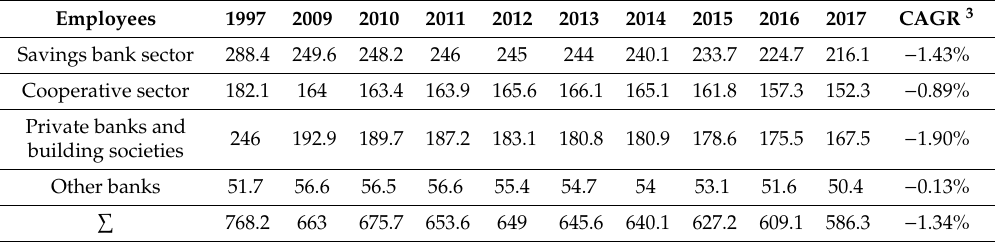
Table 2. Employees by bank groups 1997–2017 in